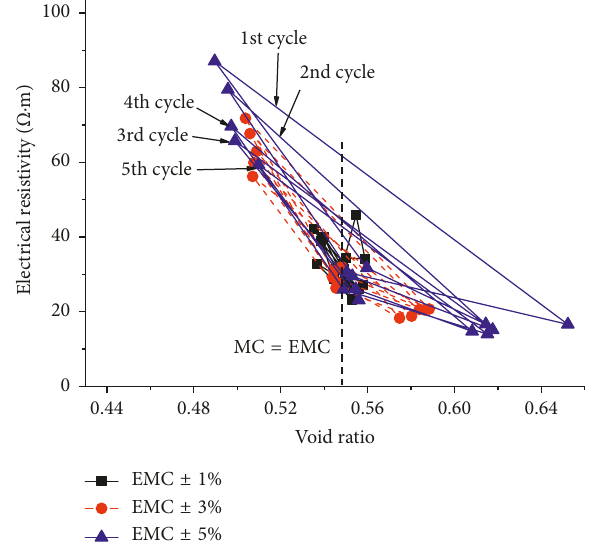
Figure 13: Relationship between void ratio and electrical resistivity during wetting-drying cycles.